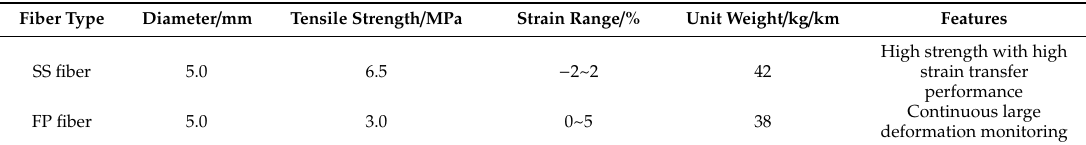
Table 1. Specification of optical fibers selected in the